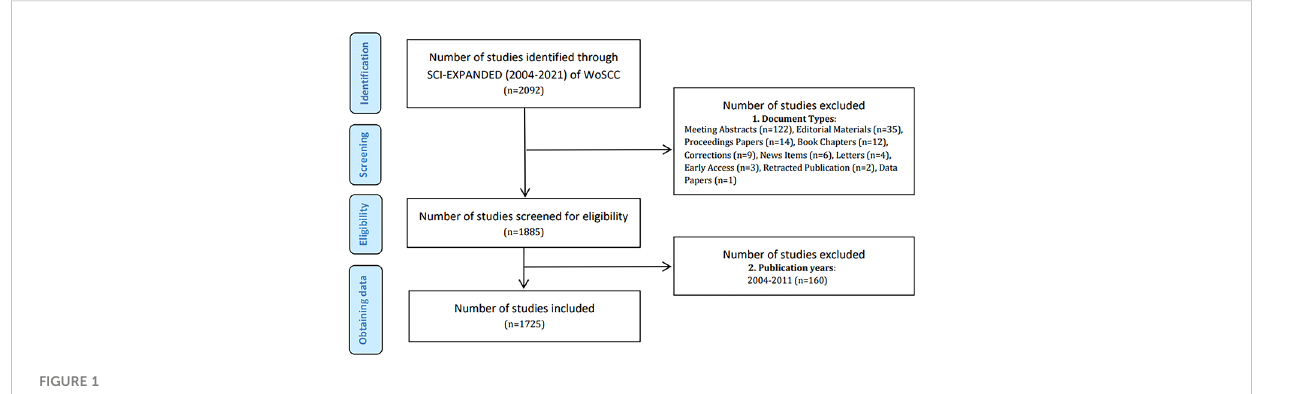
FIGURE 1 Flow chart of literature screening in